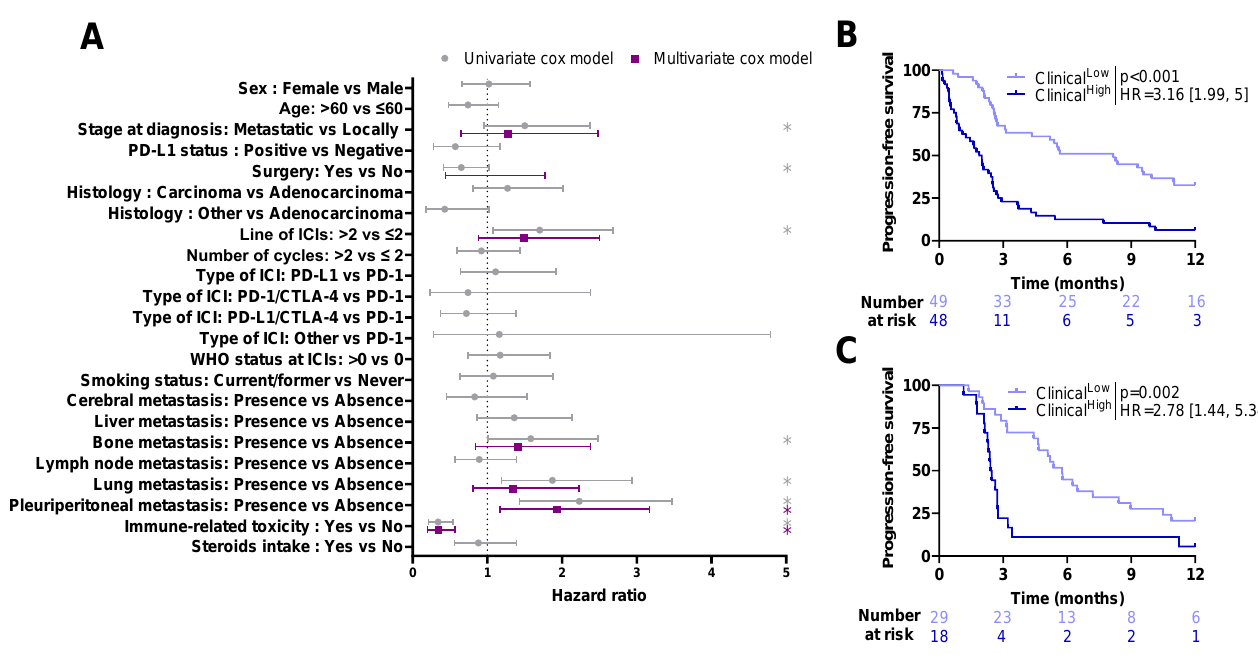
Figure 3. Association between progression-free survival and clinical variables: ( A ) Forest plots representing hazard ratios and confidence intervals for univariate (grey) and multivariate (purple) Cox models for progression-free survival estimated using clinical variables in the training cohort. *: Log-rank test p-value≤0.1. (B-C) Kaplan-Meier curves with patients stratified according to the clinical model dichotomized by training median (High vs Low) for progression-free survival for training cohort (B) and validation cohort (C). ICI: Immune Checkpoint Inhibitor, PD-L1: Programmed Death-Ligand 1, PD-1; Programmed cell Death protein-1, CTLA-4: Cytotoxic T Lymphocyte-Associated protein 4, WHO: World Health Organization